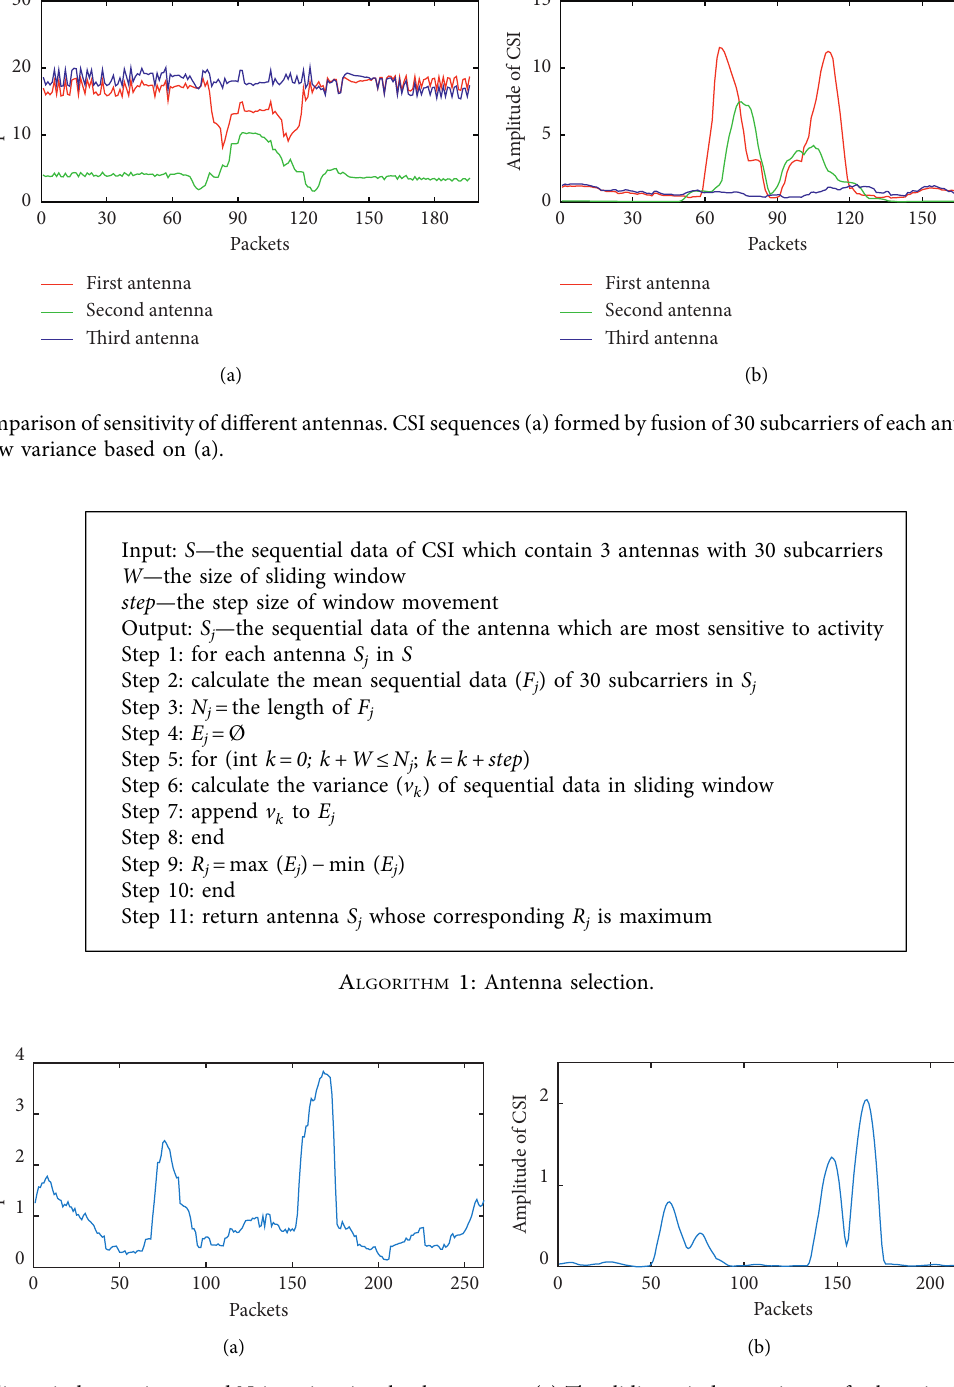
Figure 5: Sliding window variance and N-iterative signal enhancement. (a) The sliding window variance of subcarrier No. 24 of bending action; (b) N-iterative signal enhancement of No. 24 subcarrier of